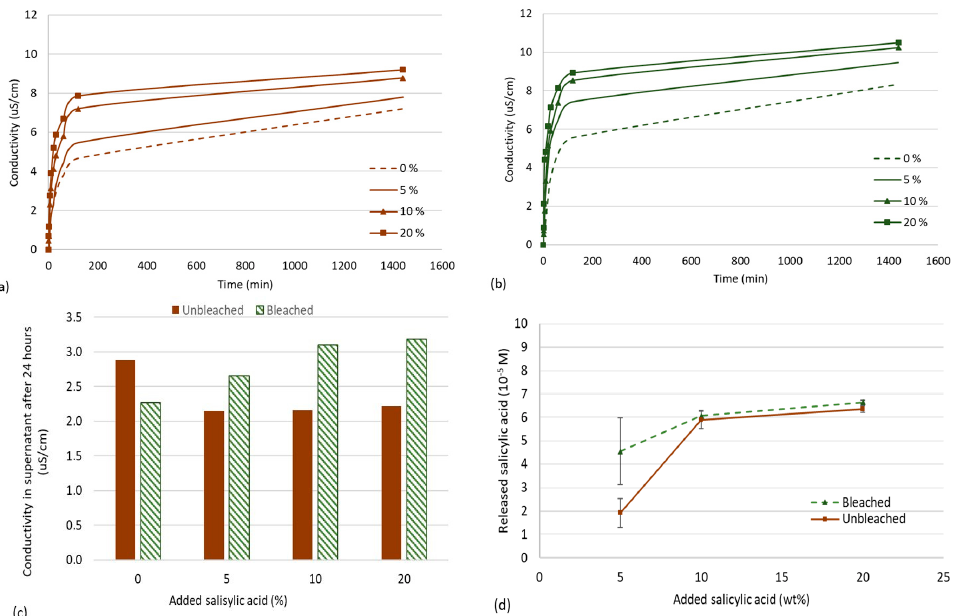
Figure 6. Conductivity measurements were performed over 24 h on ( a ) bleached CNFs and ( b